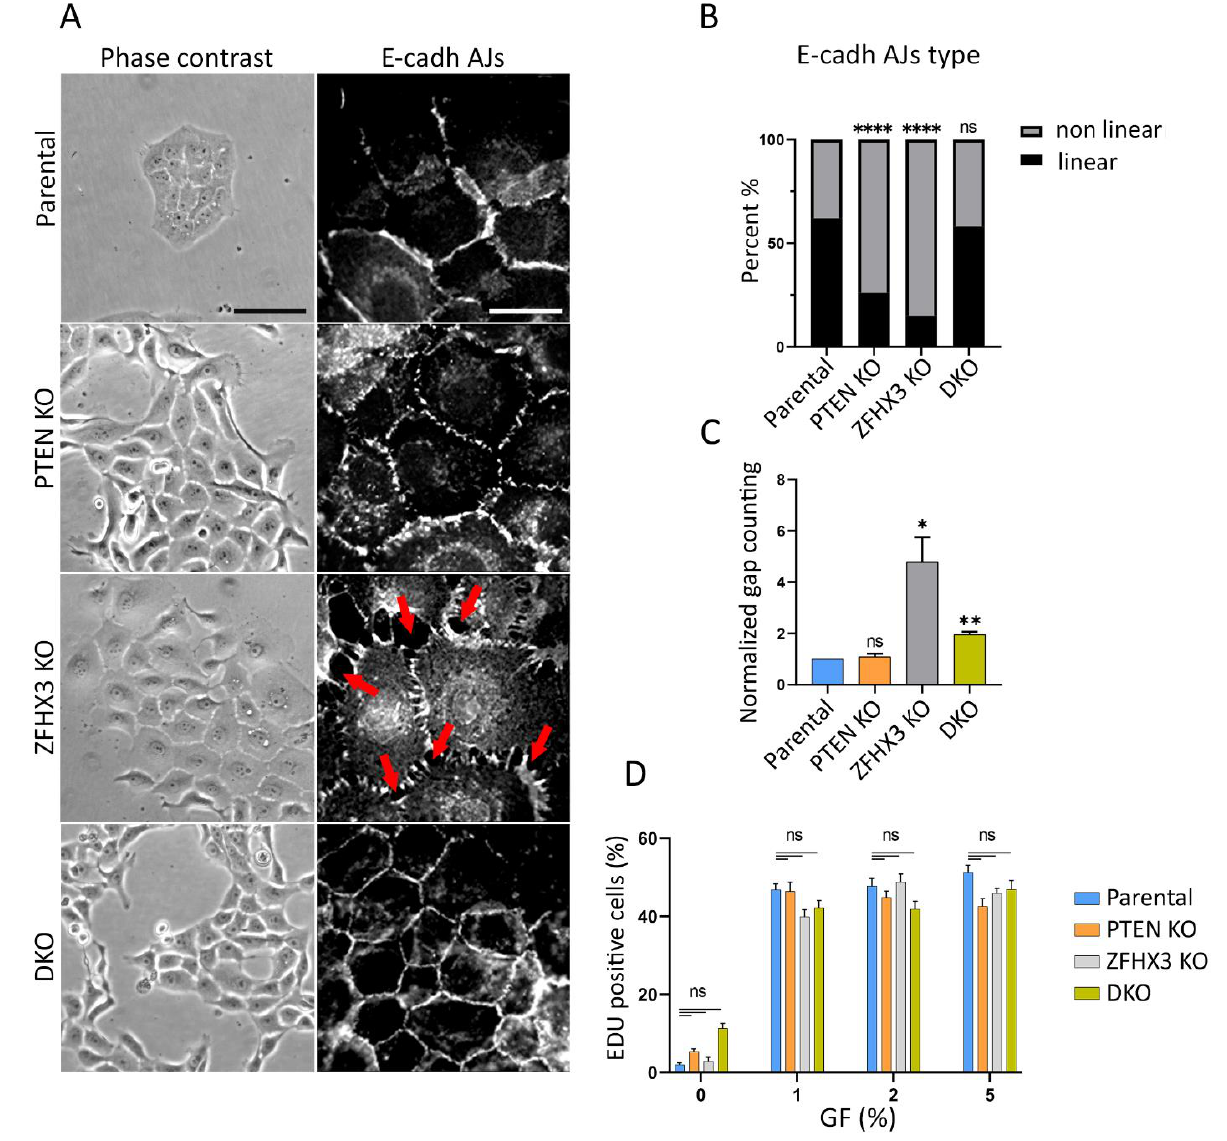
Figure 1. Effect of PTEN and ZFHX3 knockouts on morphology, cell–cell adherences and proliferation activity of MCF10A cells. ( A ) Phase contrast view and E-cadherin AJs (immunofluorescence) of cells cultivated in depleted medium (1% of horse serum) and no EGF (epidermal growth factor). Red arrows point to gaps between cells. Scale bars 100 μm for phase contrast pictures and 20 μm for immunofluorescence. ( B ) Quantification of E-cadherin linear and non-linear AJs within islets of parental and KOs cells. ( C ) Quantification of gaps between cells in cell islets. The data ( B , C ) represent 3 independent experiments, Sample size (the number of calculated AJs) for each experiment is: Parental 155, 114, 199; PTEN KO 86, 87, 159; ZFHX3 KO 98, 91, 161; DKO 136, 116, 189 junctions for ( B , C ). ( D ) Analysis of proliferation of obtained cells. The percentage of cells in S-phase was determined as a ratio of EdU—positive nuclei/DAPI-stained nuclei. The data represent 3 independent experiments. Measurements were performed from 6 different fields of view ( N = 600 − 1000). Statistical analysis was performed by a contingency Chi square test in ( B) ; unpaired t -test in panel ( C) , Kruskal–Wallis test in panel ( D ); * p < 0.05, ** p < 0.01, **** p < 0.0001 and ns: non-significant.